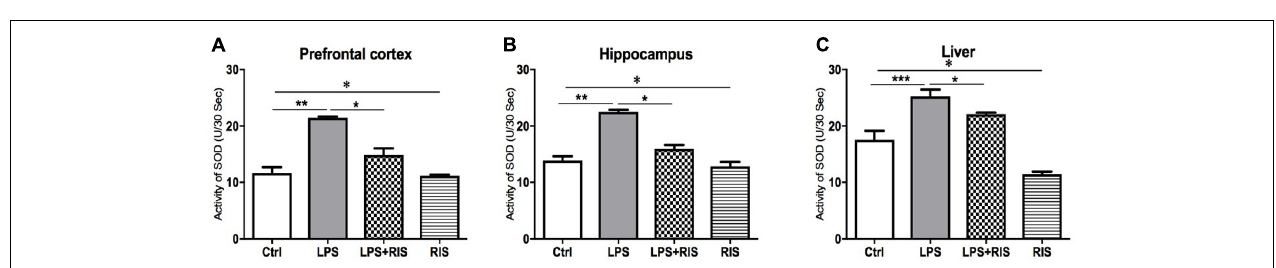
FIGURE 5 | Effect of various treatments on the activity of superoxide dismutase (SOD). Groups are Ctrl (control), LPS (lipopolysaccharide), LPS+RIS (lipopolysaccharide + risperidone), and RIS (risperidone). SOD activity was measured from the prefrontal cortex (A) , hippocampus (B) , and liver (C) tissues. Values are represented as mean ± SEM. Post hoc multiple comparison test namely, “Newman–Keuls” test was used to compare between groups. n = 6 per group. ∗ p < 0.05, ∗∗ p < 0.01, ∗∗∗ p <